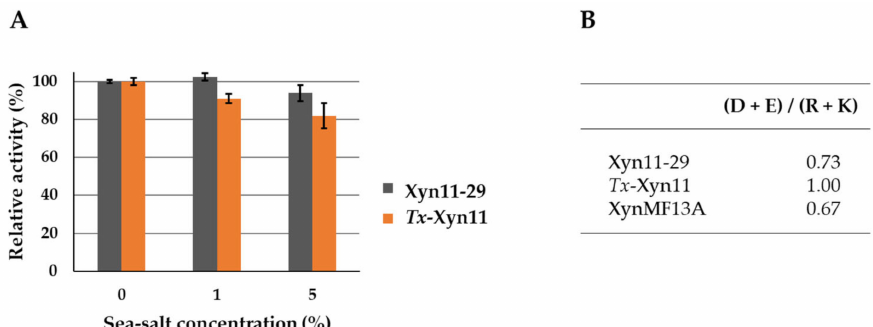
Figure 6. Sea salt effect on Xyn11-29 xylanase activity and ratios of negatively to positively charged amino acids for Xyn11-29, T. xylanolyticus , Tx -Xyn11, and Phoma sp. xylanase, XynMF13A. ( A ) Sea salt was used at concentrations of 1% and 5%. Activities are expressed as a percentage of the activity without sea salt (set to 100%). Each data point (mean +/ − standard deviation) is the result of triplicate experiments. ( B ) Negatively charged (D + E) to positively charged (R + K) amino acid